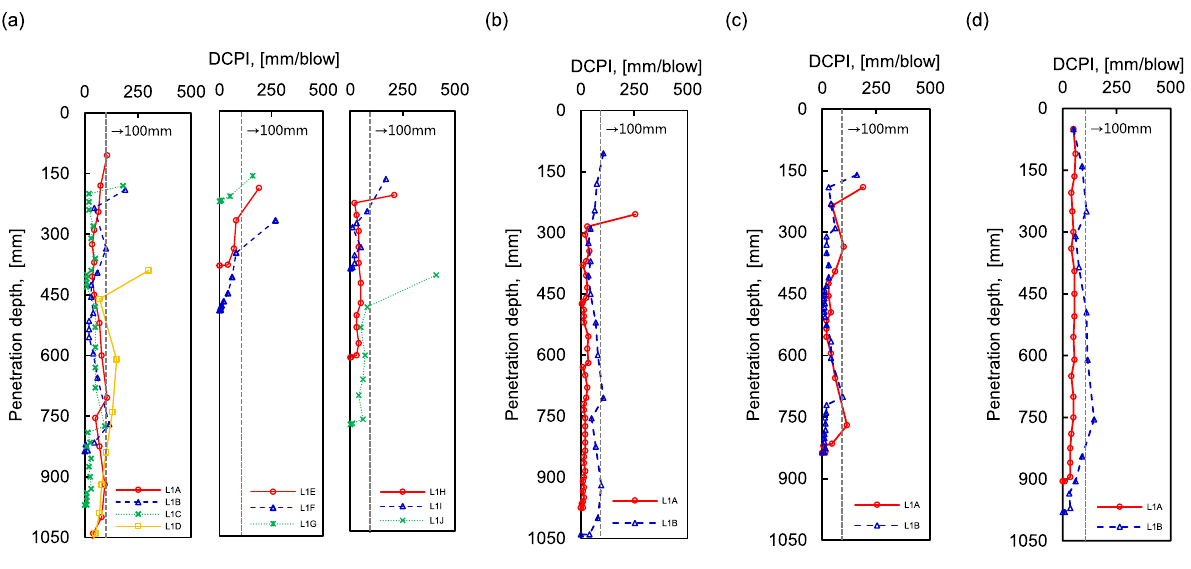
Figure 5. DCPT results: ( a ) line 1; ( b ) line 2; ( c ) line 3; ( d ) line